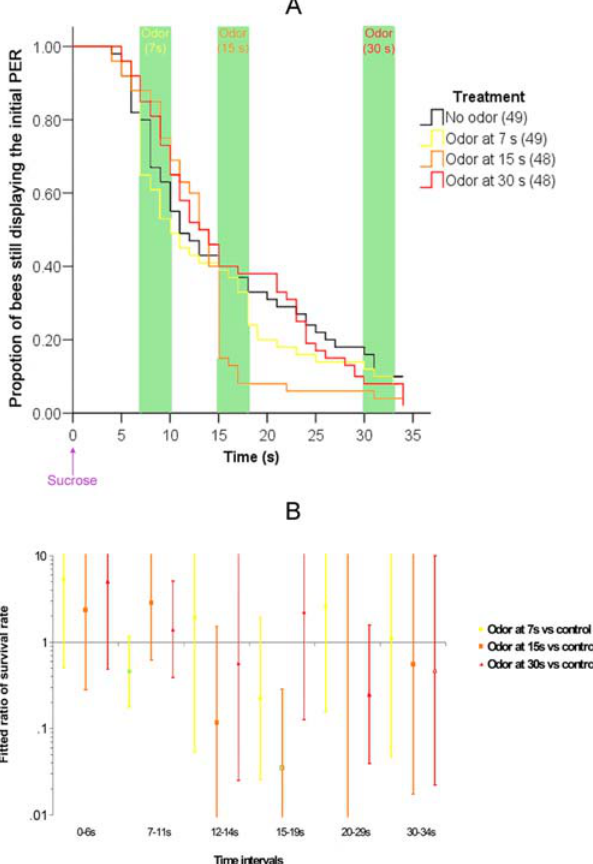
Figure 2. Olfactory interference tested at 7, 15 and 30 s: time course of the PER (A) and fitted ratio of survival rate (B). This